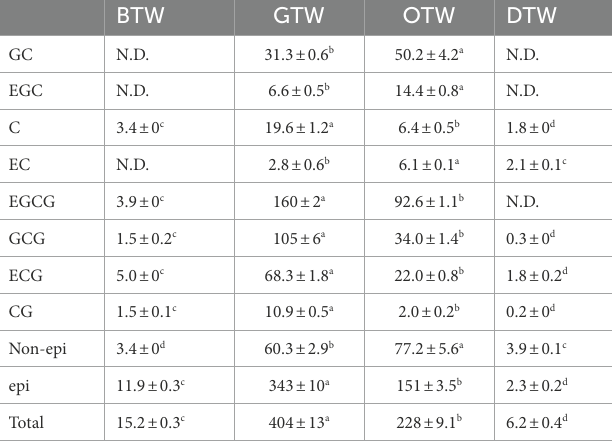
TABLE 1 The concentrations of catechins in tea wine samples